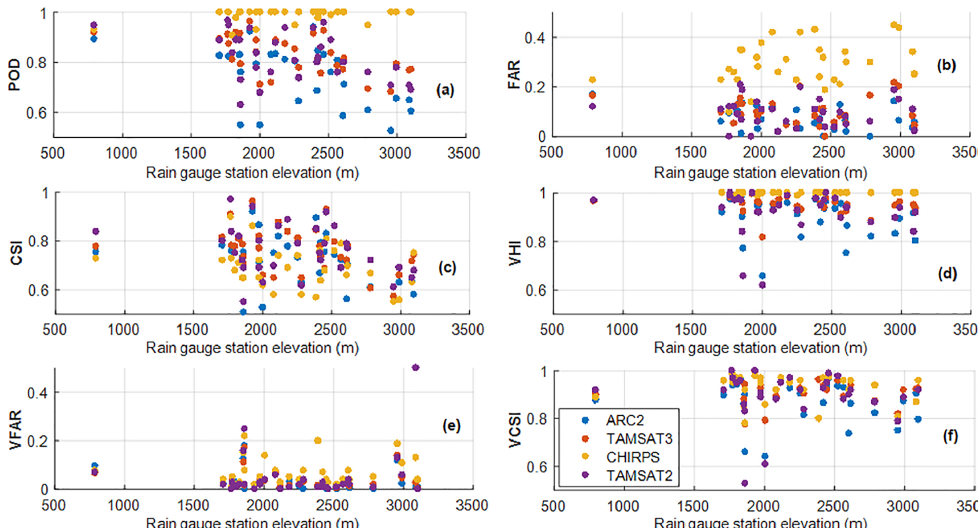
Figure 5. Categorical and volumetric indices of satellite rainfall products as a function of elevation: (a) probability of detection (POD), (b) false alarm ratio (FAR), (c) critical success index (CSI), (d) volumetric hit index (VHI), (e) volumetric false alarm ratio (VFAR), and (f) volumetric critical success index (VCSI) over the Upper Blue Nile basin for the period of 2000–2015.